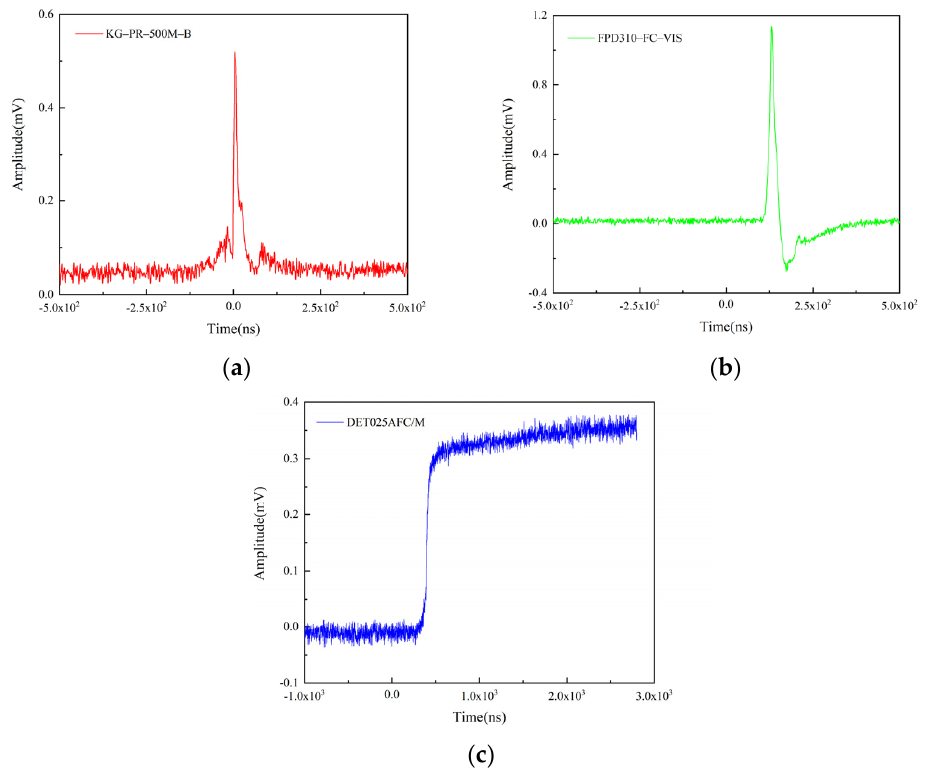
Figure 4. Typical signals of: ( a ) KG-PR-500M-B, ( b ) FPD310-FC-VIS, and ( c ) DET025AFC/M.